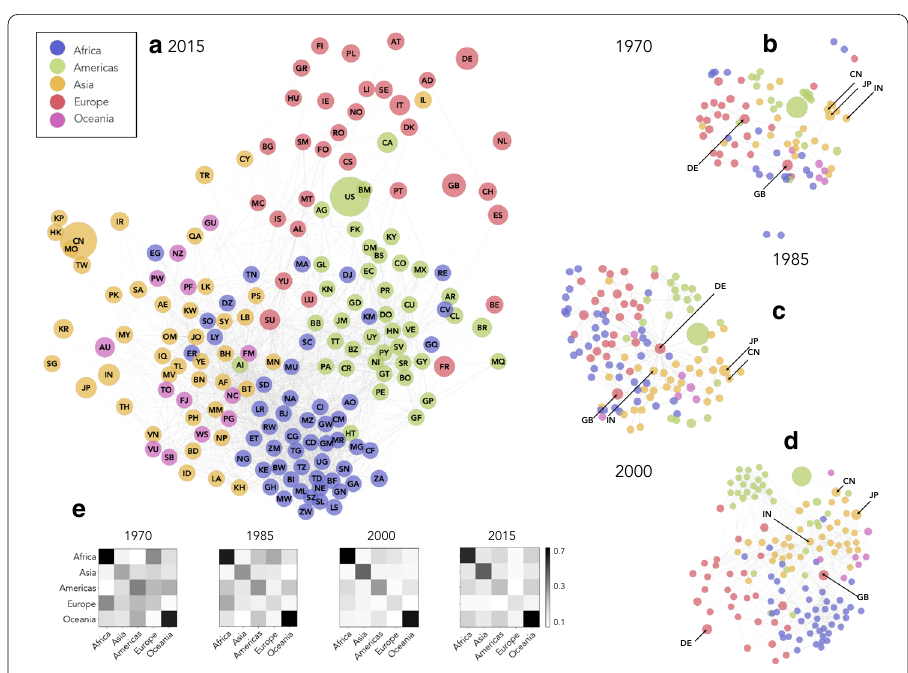
Fig. 4 a The global collaboration network constructed for data between 2015–2018. The algorithm ForceAtlas is used to layout the network, with edges above a 0.5 edge-weight threshold shown. Node sizes are scaled according to the total number of publications during this period, labeled with the ISO2 code corresponding to each country, and coloured according to geographical regions. b – d show analogous networks constructed for periods 1970–1974, 1985–1989, and 2000–2004. Finally, e displays mean edge weights between the five continents in the form of adjacency matrices. We observe a concentration of edge weights within regions, as seen by the shaded diagonal entries, particularly from 2000. Colours correspond to the same continent in each